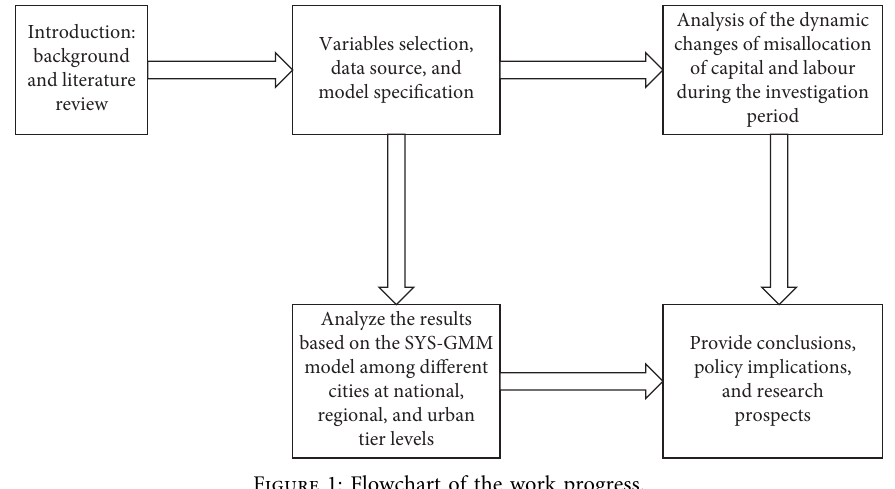
Figure 1: Flowchart of the work